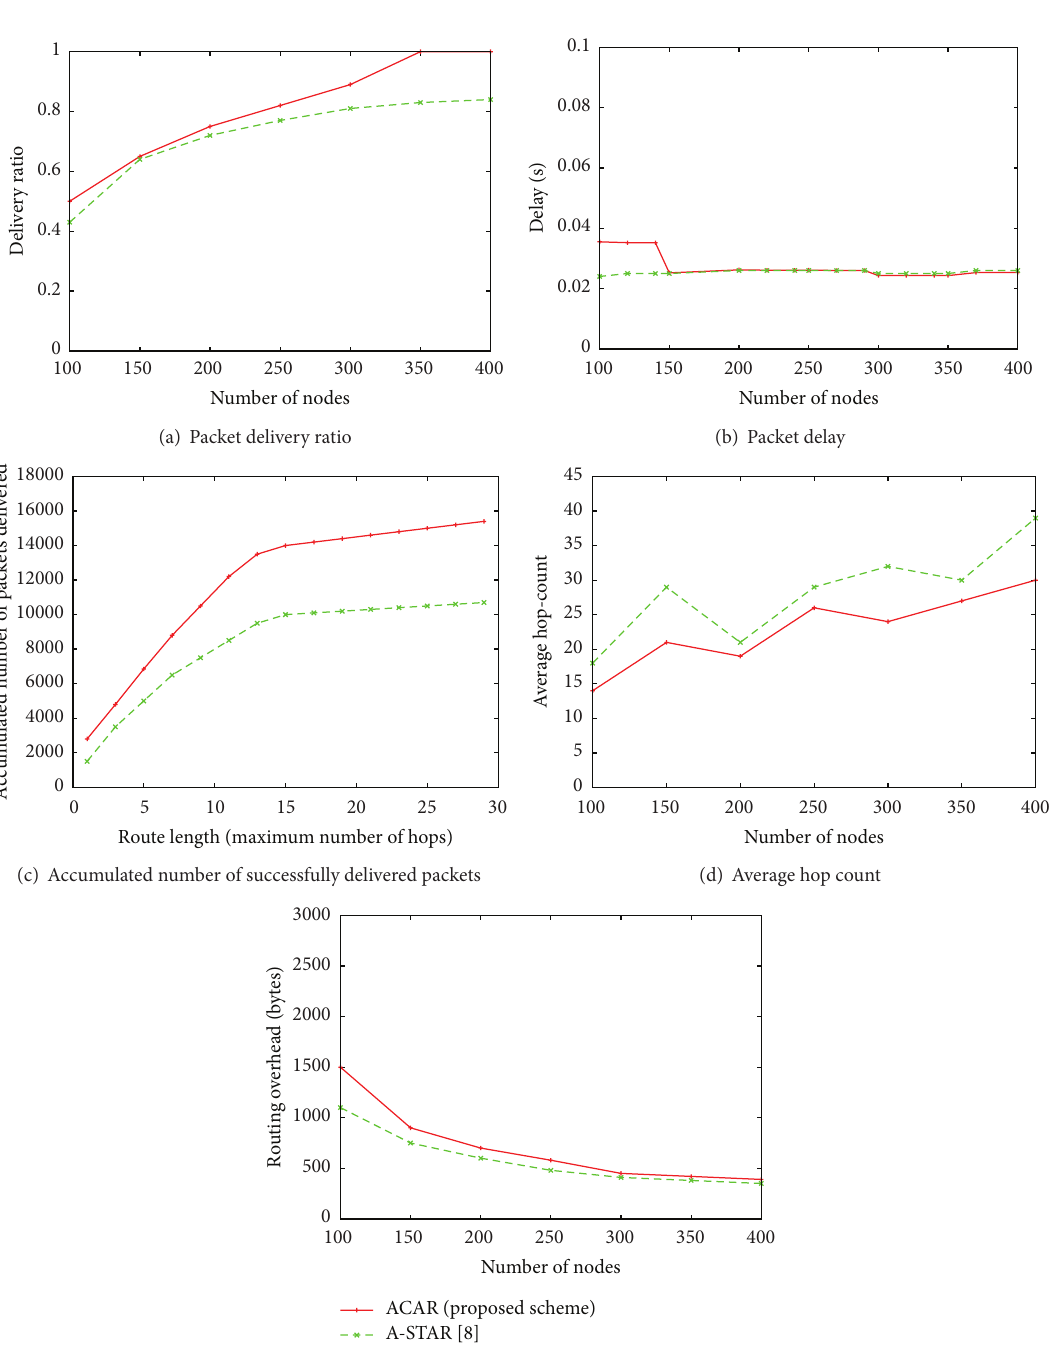
Figure 6: Performance comparison between ACAR (the proposed scheme) and A-STAR according to the number of nodes in terms of packet delivery ratio, packet delay, accumulated number of successfully-delivered packets, average hop-count, and routing overhead when the node vehicle’s speed is 50km/h, the radio range of node is 200m, and maximum number of hops is